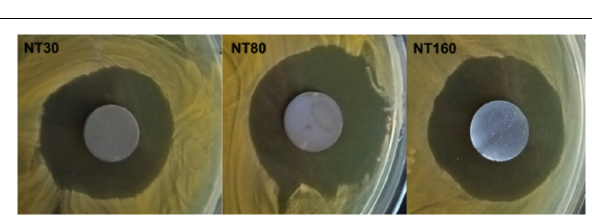
TABLE 2 | Estimated loading efficiency of gentamicin in TiO 2 nanotubes.